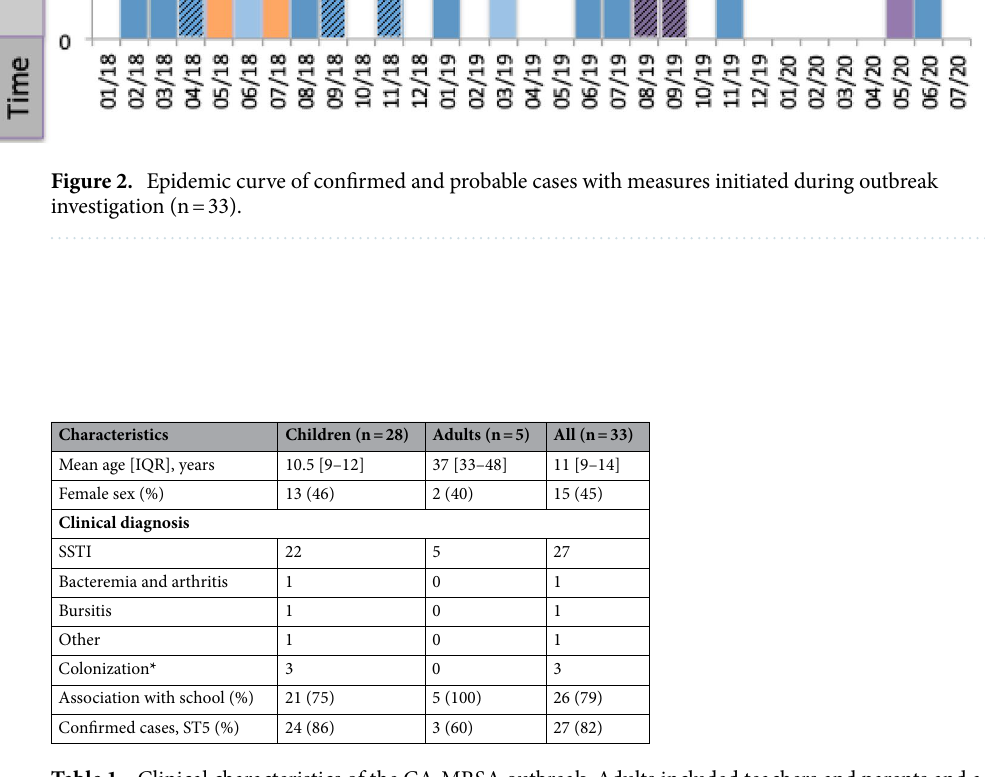
Table 1. Clinical characteristics of the CA-MRSA outbreak. Adults included teachers and parents and a teacher’s wife. IQR interquartile range, SSTI skin and soft tissue infection, ST5 sequence type 5. * Colonized students were identified in the cross-sectional